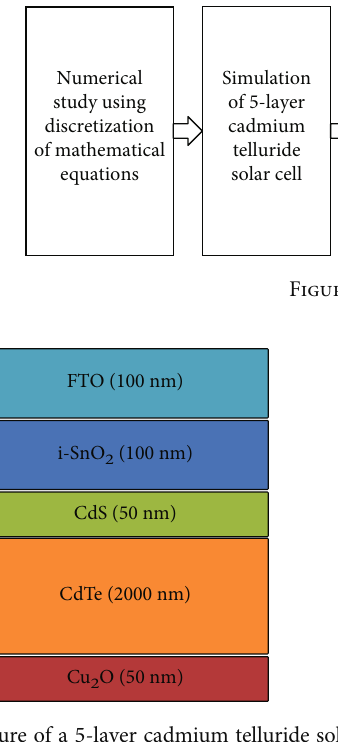
Figure 2: Structure of a 5-layer cadmium telluride solar cell.